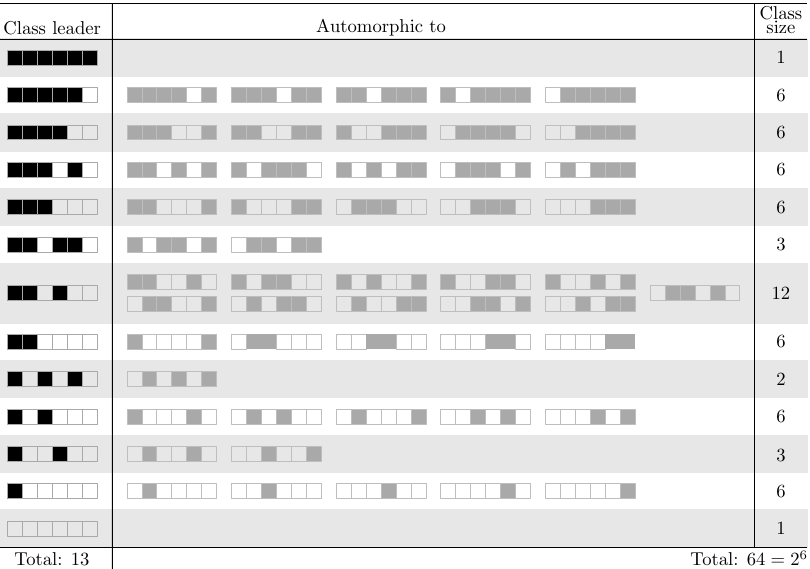
Table 1: The thirteen automorphism class leaders of game states (as well as their corresponding full automorphism classes) for the case where the underlying graph is a 6 -cycle. The right-most cell of each linear array wraps around to form a cycle with the left-most cell. A solid cell represents a cooperator, while an open cell represents a